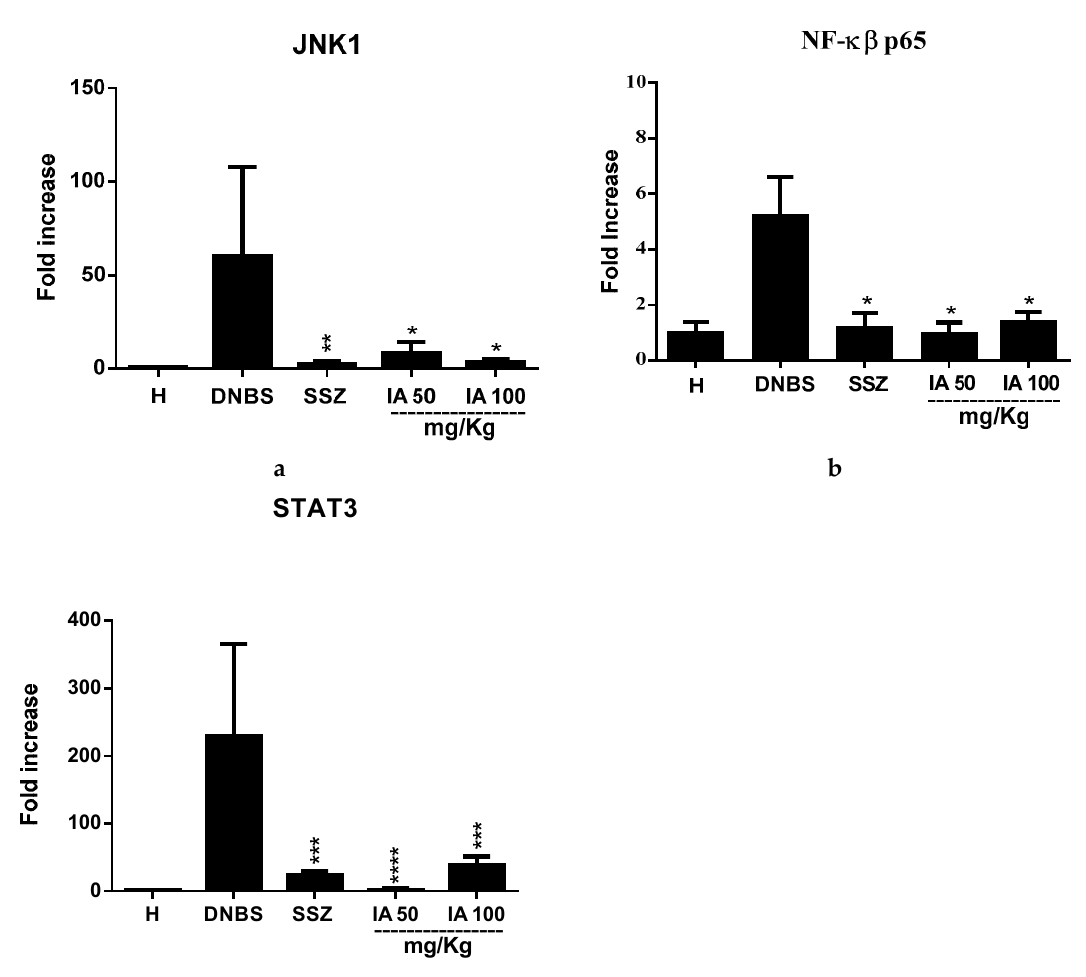
Figure 2. Effect of 50 and 100 mg/kg doses of I. asarifolia (IA) aqueous extract and 250 mg/kg sulfasalazine (SSZ) on the gene expression of c-Jun N-terminal kinases 1 (JNK1) ( a ), Nuclear factor kappa β (NK- κβ -p65) ( b ) and Activator of transcription 3 (STAT3) ( c ) in colonic tissue of the experimental trial of acute colitis induced by 2,4-dinitrobenzene sulfonic acid (DNBS) in rats. H, Healthy group; DNBS, DNBS group; SSZ, sulfasalazine group; and 50 and 100 mg/kg doses of the IA group. Data are expressed as mean ± SEM, ( n = 8). Statistical differences * p < 0.05, ** p < 0.01, *** p < 0.001 and **** p < 0.0001 of treatments vs. DNBS control were presented.